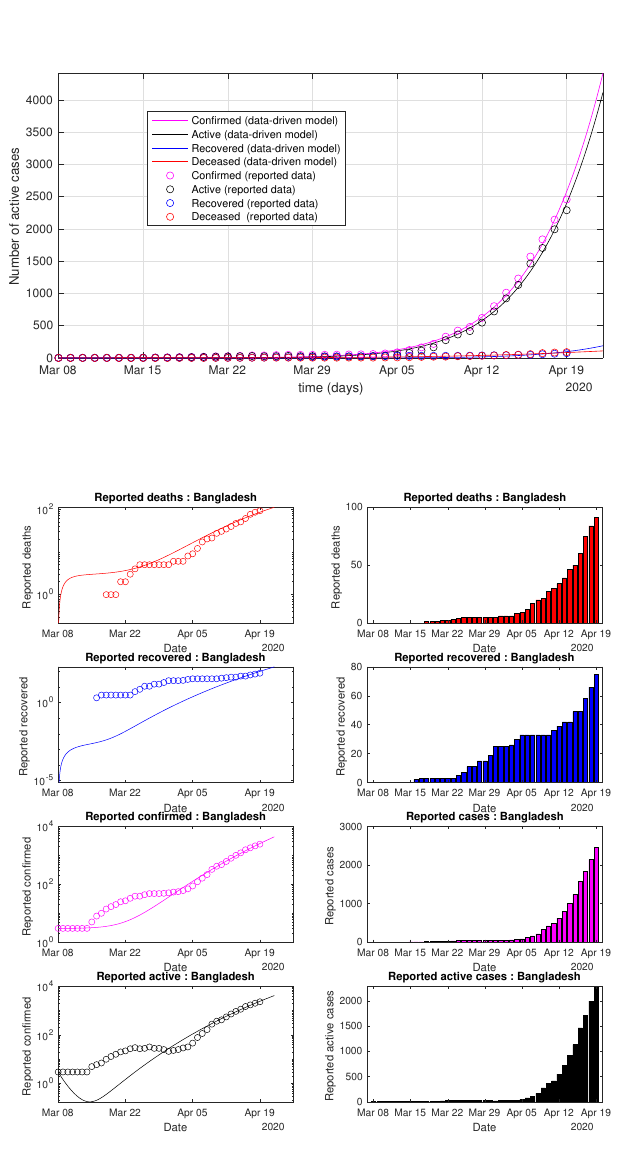
Figure 34. Bangladesh: data of active, recovered, deceased (in circle or bar) vs. model of active, recovered, deceased over time. Tracking the number of active cases. Predictive analytics for the next couple